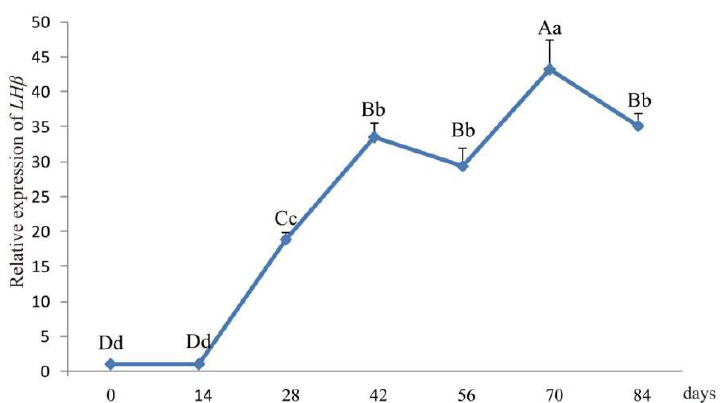
Figure 4. Developmental changes in hypophyseal LH β mRNA expression in lambs aged 0–84 days. Note: Different capital letters indicate an extremely significant differences ( p < 0.01), and different lowercase letters indicate a significant difference ( p < 0.05).